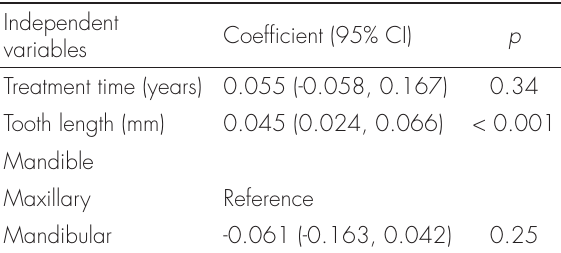
Table V. Regression coefficients predicting